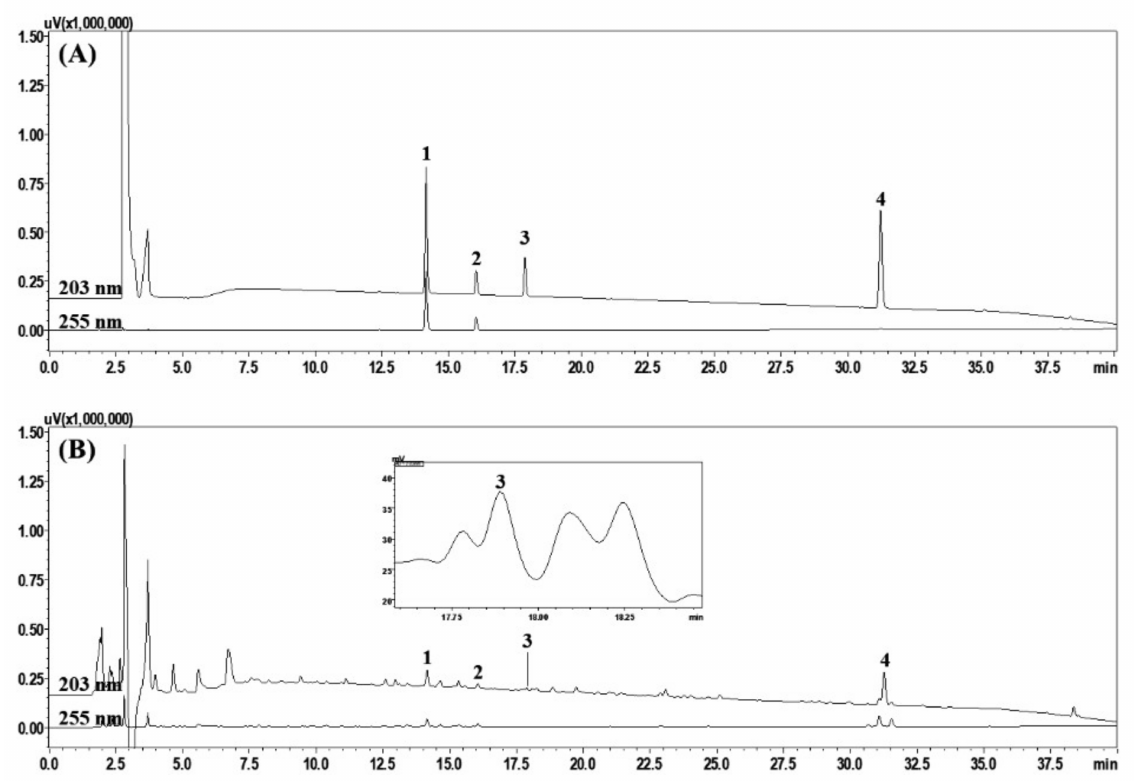
Figure 1. Representative HPLC chromatograms of ( A ) a standard solution and ( B ) 70% methanol extract of Daegunjoong- tang (DGJT) samples, at 203 and 255 nm. Hyperoside ( 1 ), quercitrin ( 2 ), ginsenoside Rg1 ( 3 ), and 6-gingerol ( 4